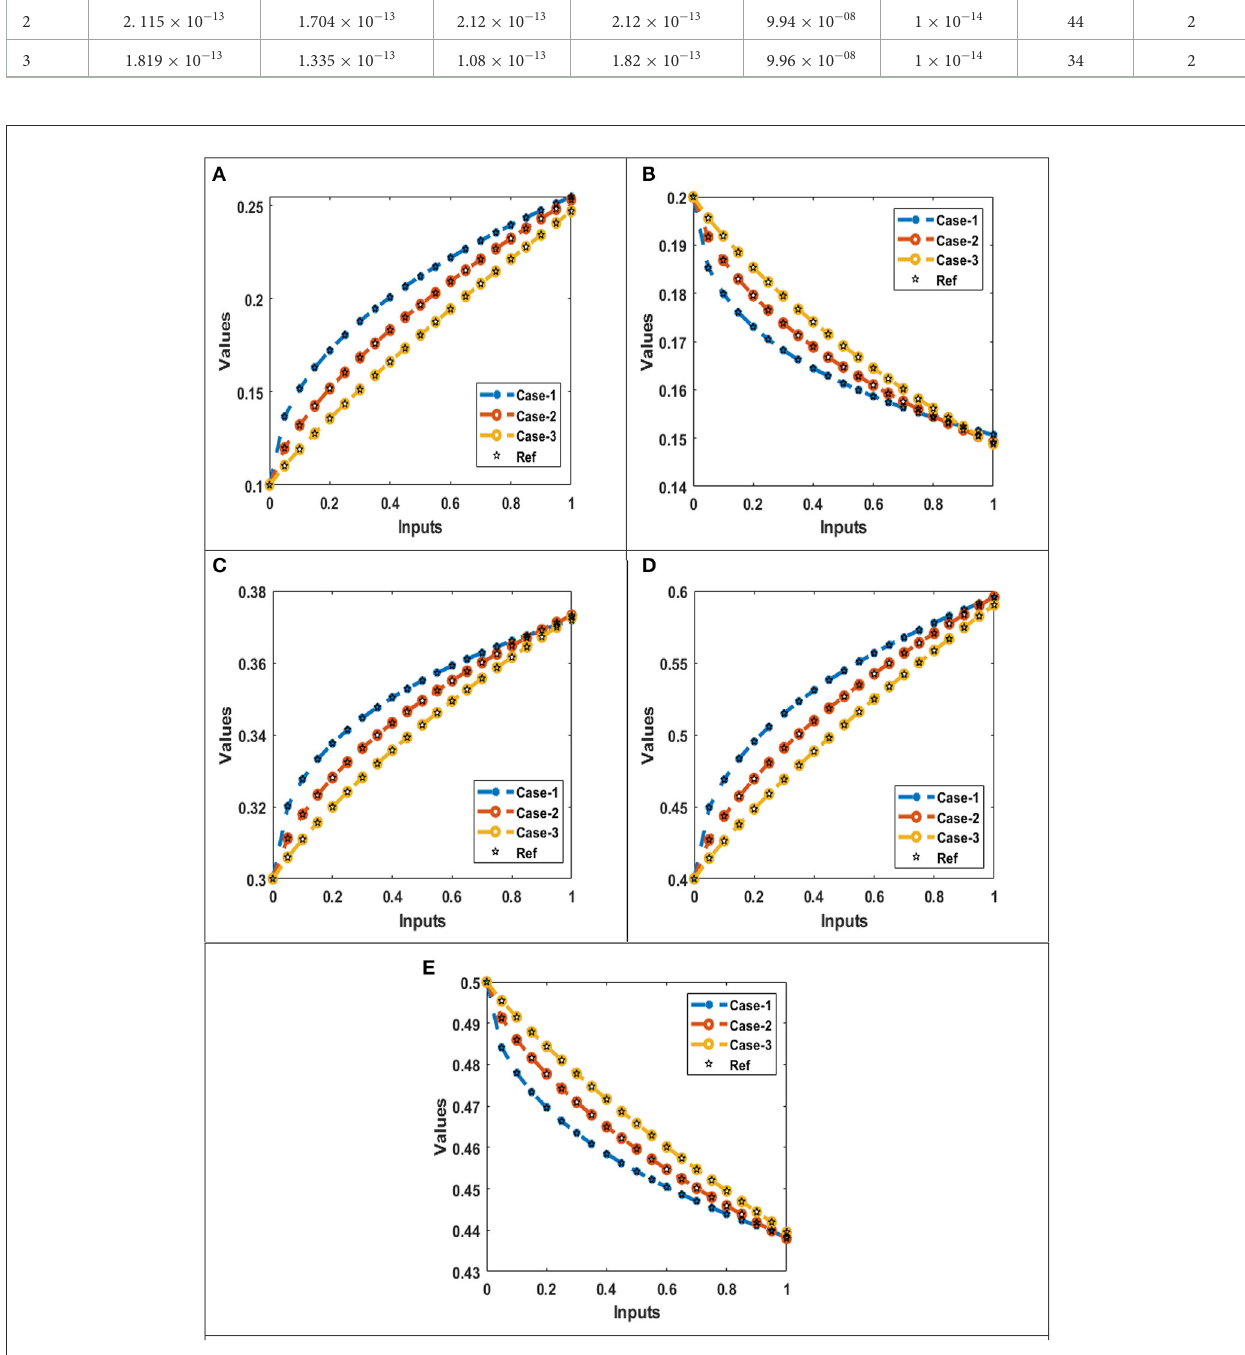
FIGURE12 Comparison of the performances for the integer order system. (A) AE: X ( t ). (B) AE: Y ( t ). (C) AE: W ( t ). (D) AE: R ( t ). (E) AE: Z ( t ).